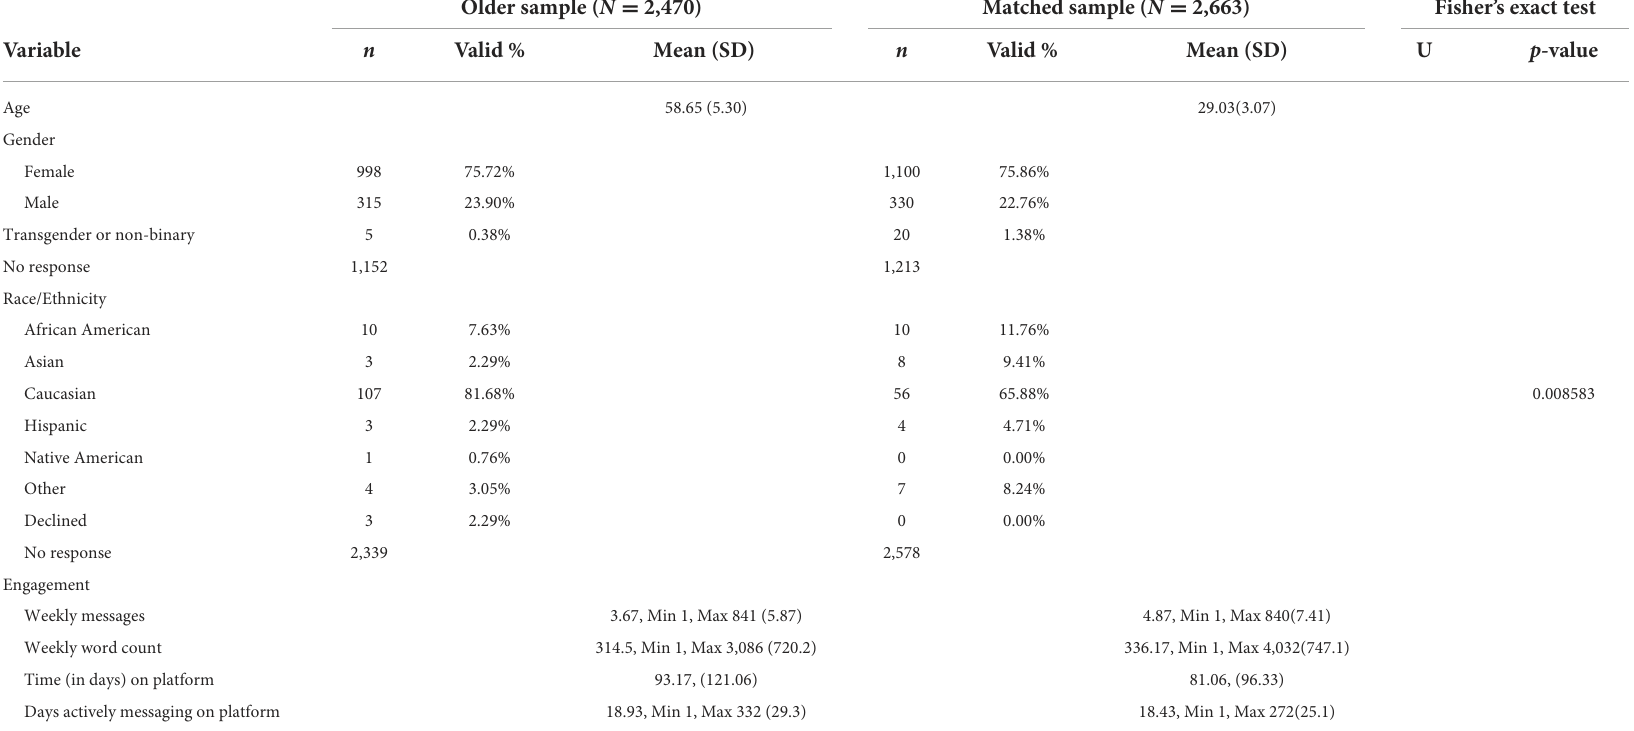
TABLE 1 Demographic characteristics and treatment engagement ( N =